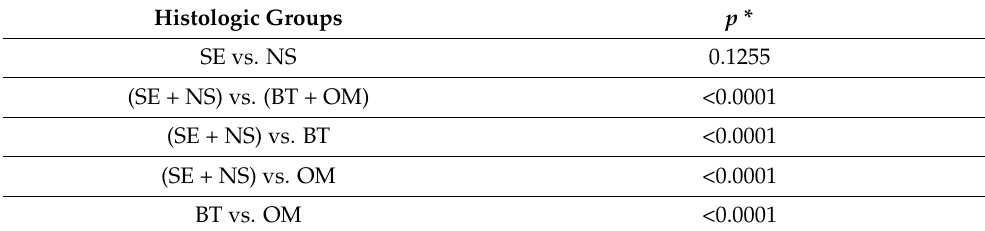
Table 3. Comparisons of median tumour sizes among particular histologic subgroups.